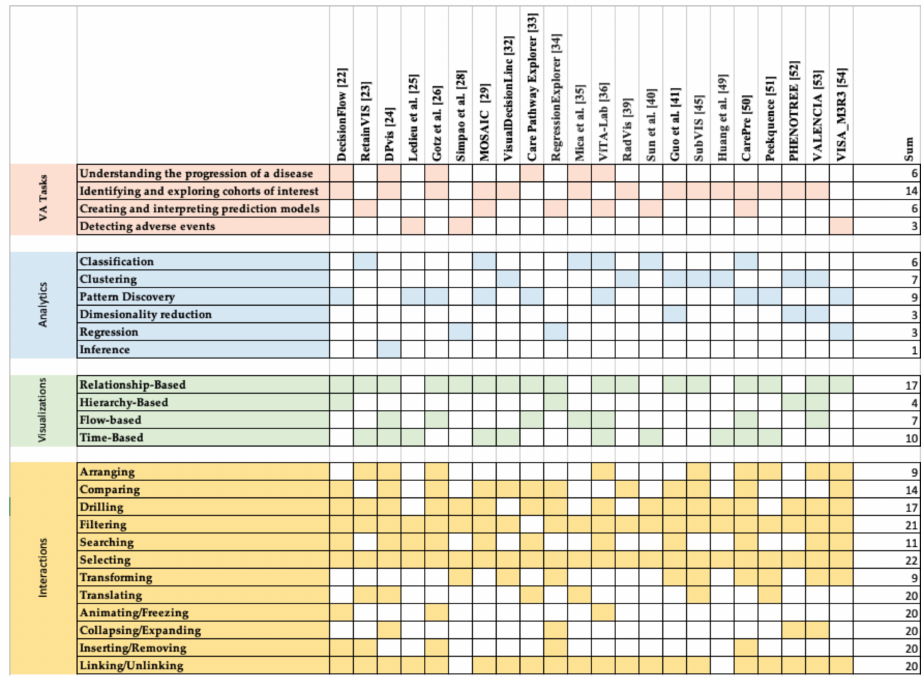
Figure 11. The reviewed EHR-based visual analytics system. Each system is labeled by the relevant element in the design space. The rows are grouped and colored by dimensions of the design space: VA tasks, analytics, visualization, and interaction